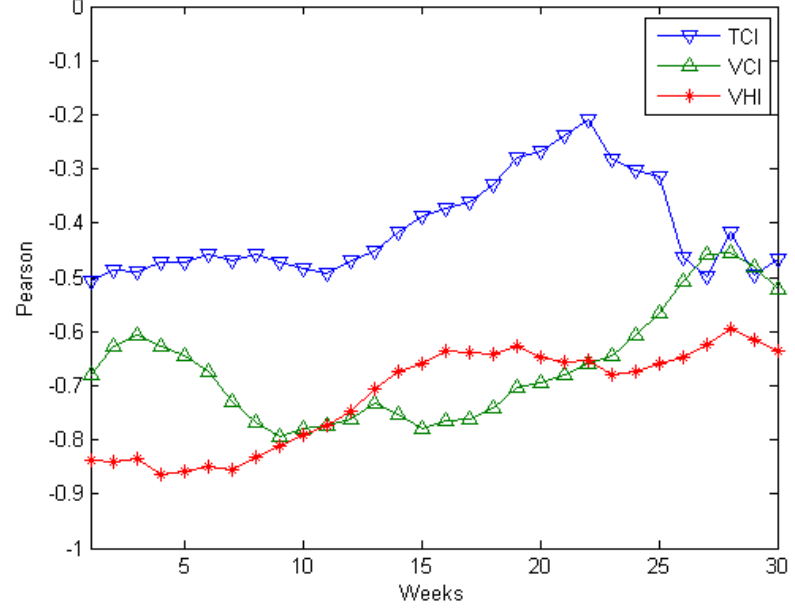
Figure 2. Correlation coefficient dynamics of the percent deviation of aus production from mean versus TCI, VCI and